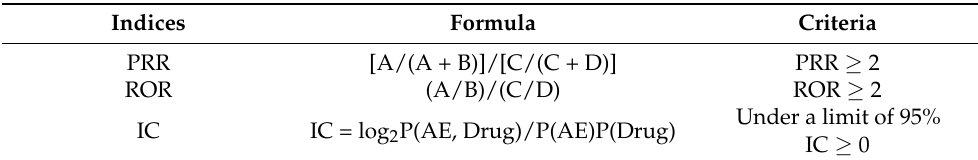
Table 2. Formulae and criteria for signal detection. Indices Formula